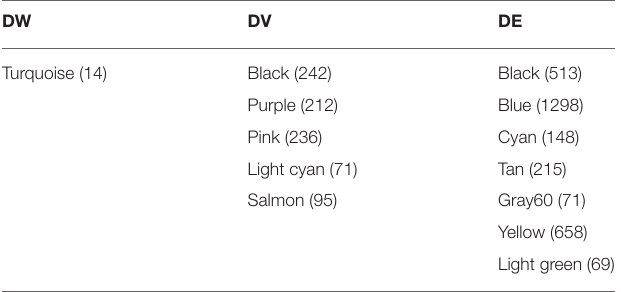
TABLE 2 | Summary measure of 18 genes identified as differentially wired hub genes in the turquoise module [kME > 0.8 and enriched in changed edges ( p < 0.01;